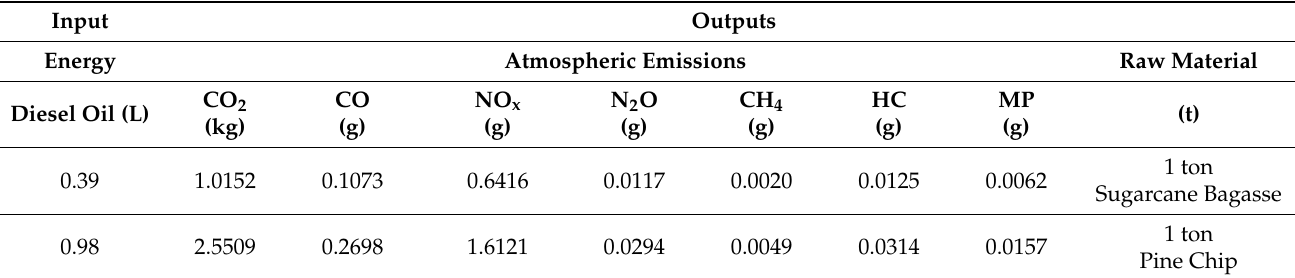
Table 1. Inputs and outputs of the sugarcane transport process.